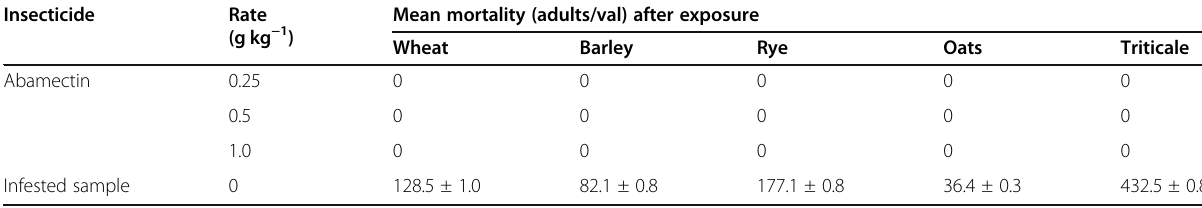
Table 3 Progeny emergence (adults/val) and reduction of Rhyzopertha dominica in 5 grain species treated with abamectin Mean mortality (adults/val) after exposure Insecticide Rate (g kg − 1 ) Wheat Barley Rye Oats Triticale